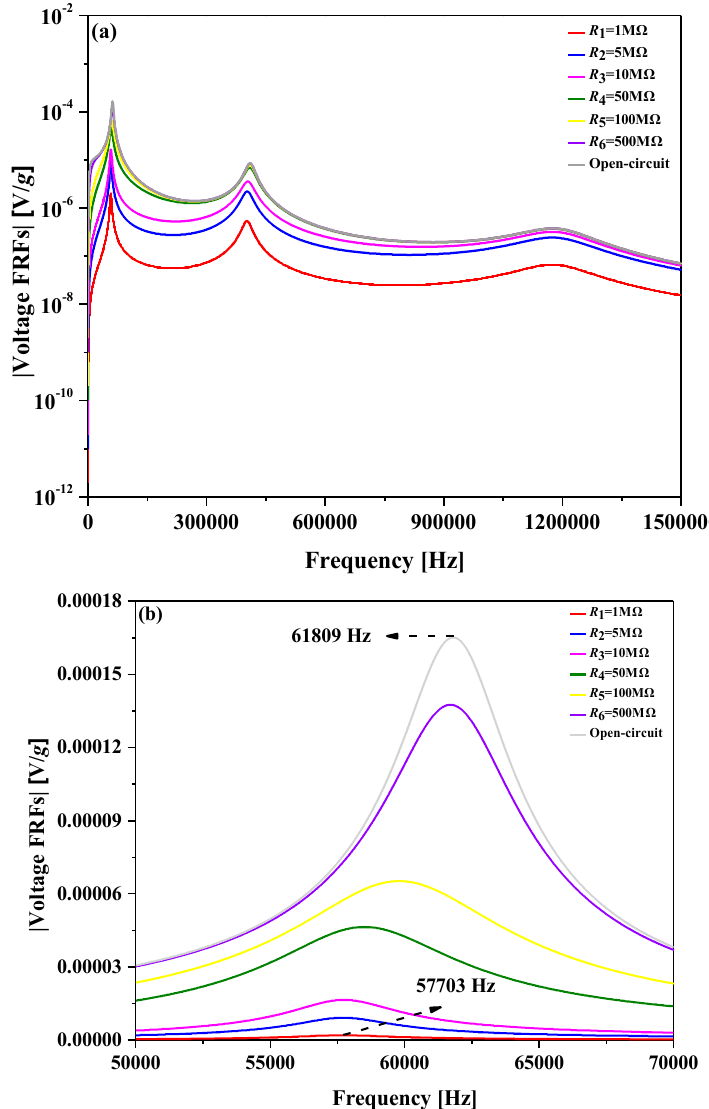
Figure 3. Voltage FRFs of the flexoelectric beam with 0.3 μm thickness over the frequency range of ( a ) the first three modes; ( b ) around the first mode.